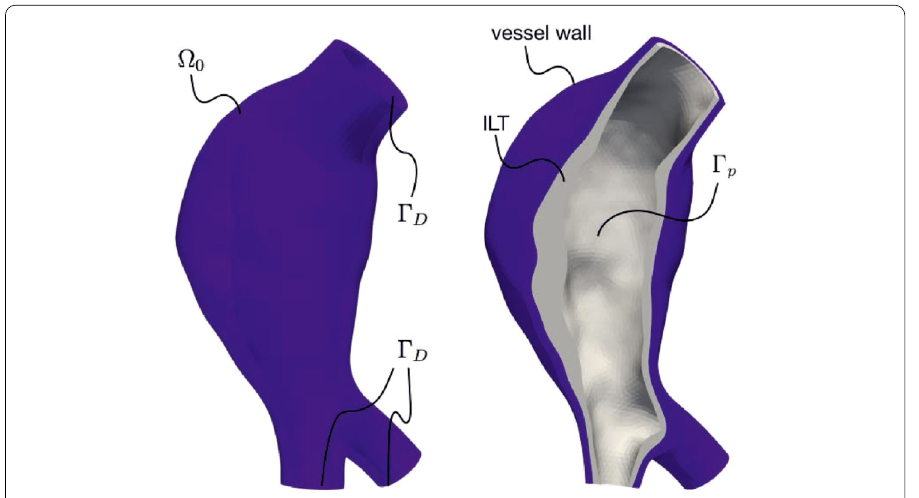
Fig. 1 Example of a patient-specific computational domain (cid:2) 0 (left) and cut through the computational domain (right) exposing the separation of (cid:2) 0 into the vessel wall and the intraluminal thrombus (ILT). (cid:3) p denotes the pressure load boundary condition surface, (cid:3) D denotes Dirichlet boundary condition